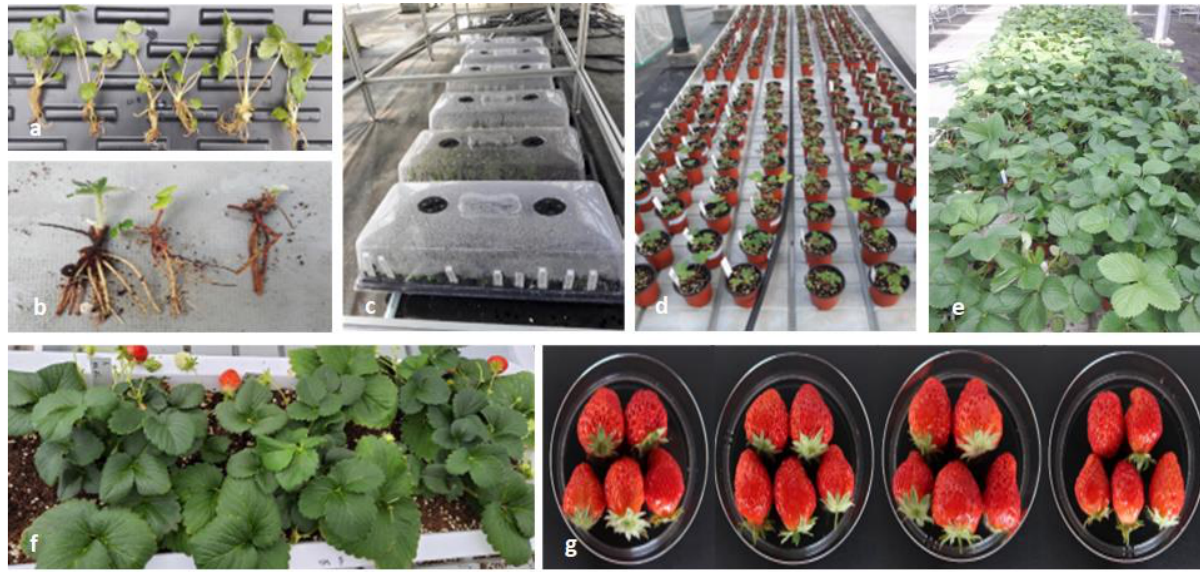
Figure 1. Strawberry plants grown in the greenhouse: ( a ) In vitro grown plants before acclimatization; ( b ) Plants detached from the mother plants (GH); ( c ) Acclimatization; ( d ) Early stage of vegetative growth; ( e ) At the stage of vegetative growth evaluation; ( f ) The beginning of the fruit set; ( g ) Harvested fruit of IT245810 from the four treatments (orders from the left: GH, greenhouse maintained; TC, tissue culture; +LN, liquid nitrogen exposure; −LN , non-liquid nitrogen exposure).